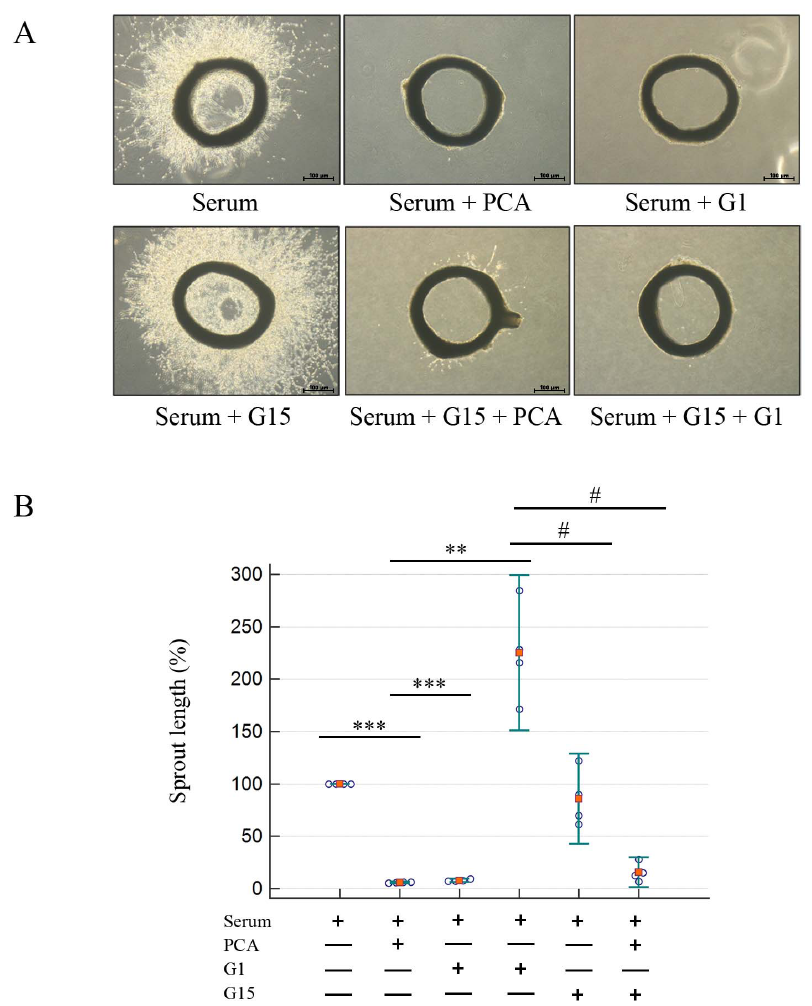
Figure 5. PCA inhibits angiogenesis. ( A ) Rat aortas were obtained from Sprague Dawley rats weighing 100 grams. Rat aorta segments placed on Matrigel were stimulated with FBS (10%) for 3 days. Then, the segments were treated with each substance for 48 hrs in media supplemented with FBS (10%). Sprout lengths were measured by using Scion Image software. ( A, B ) Values represent the means 6 SEMs of 3 experiments. *** indicates P , 0.001 compared to the control group. ## and ### indicate P , 0.005 and P , 0.001, respectively, compared to the PDGF group. 111 indicates P , 0.001 compared to the G15 group. Production will need this reference to link the reader to the figure.